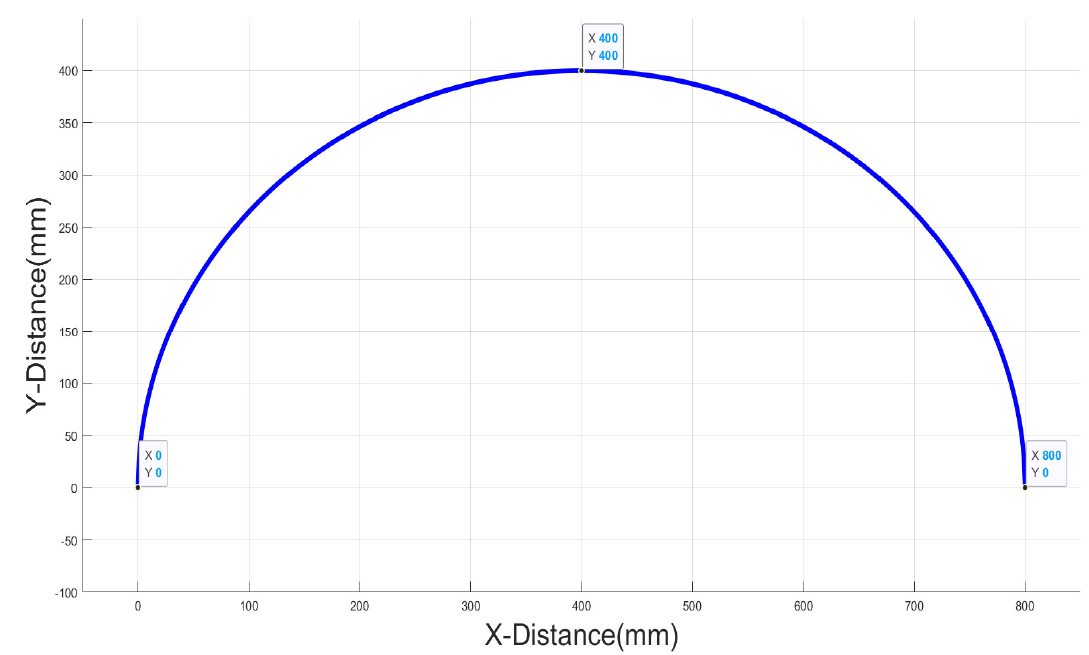
Figure 14. Chassis steering track curve.